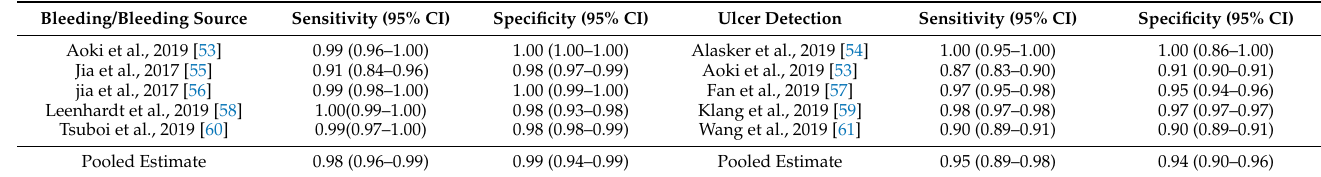
Table 4. Deep learning implementation for the detection of bleeding/bleeding source and ulcers in capsule endoscopy (data from Soffer et al.